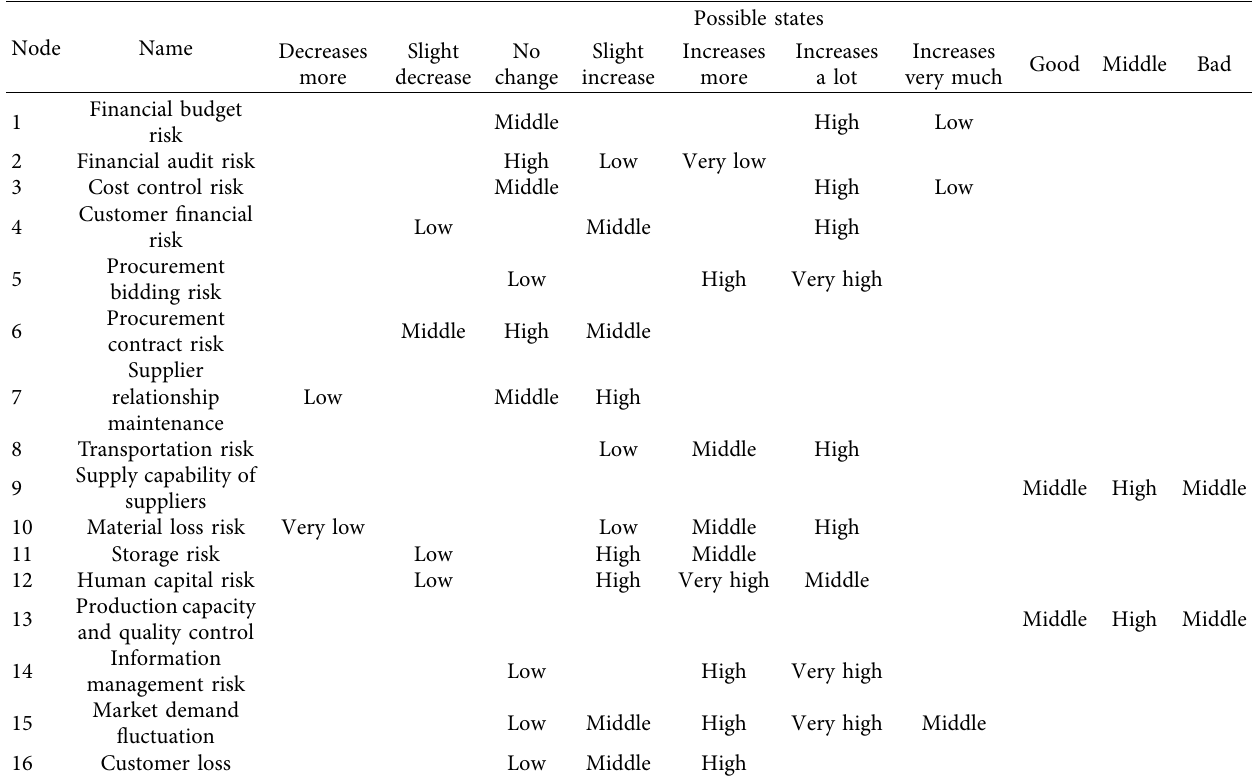
Table 1: Status and frequency of independent nodes.